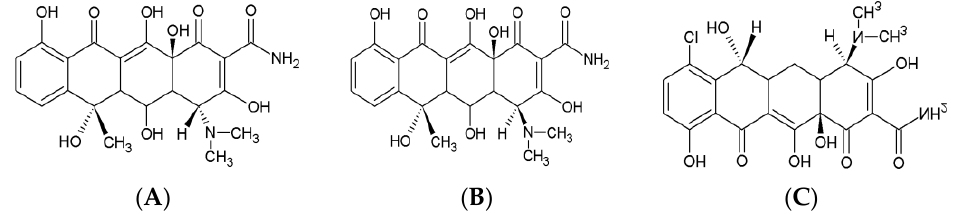
Figure 1. Chemical structures of ( A ) OTC, ( B ) 4-epi-OTC, and ( C ) DMC.